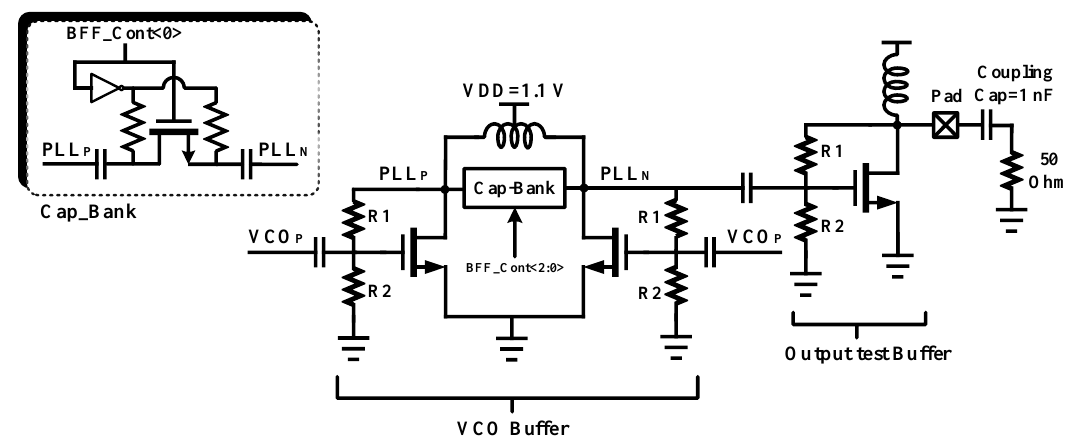
Figure 6. Schematic and simulated environment of the proposed inductive buffer.